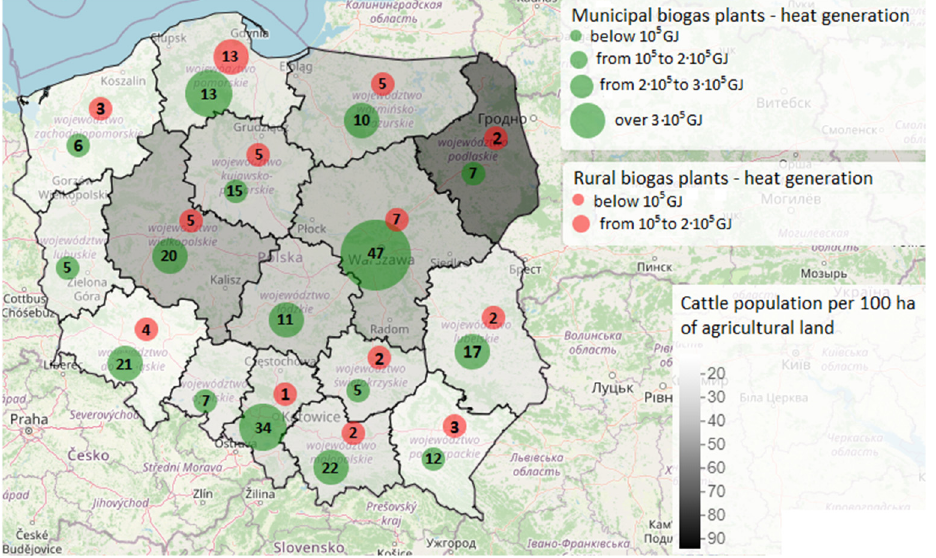
Figure 7. Number of biogas plants compared to regions (NUTS 2), including cattle populations and heat production, in 2020.